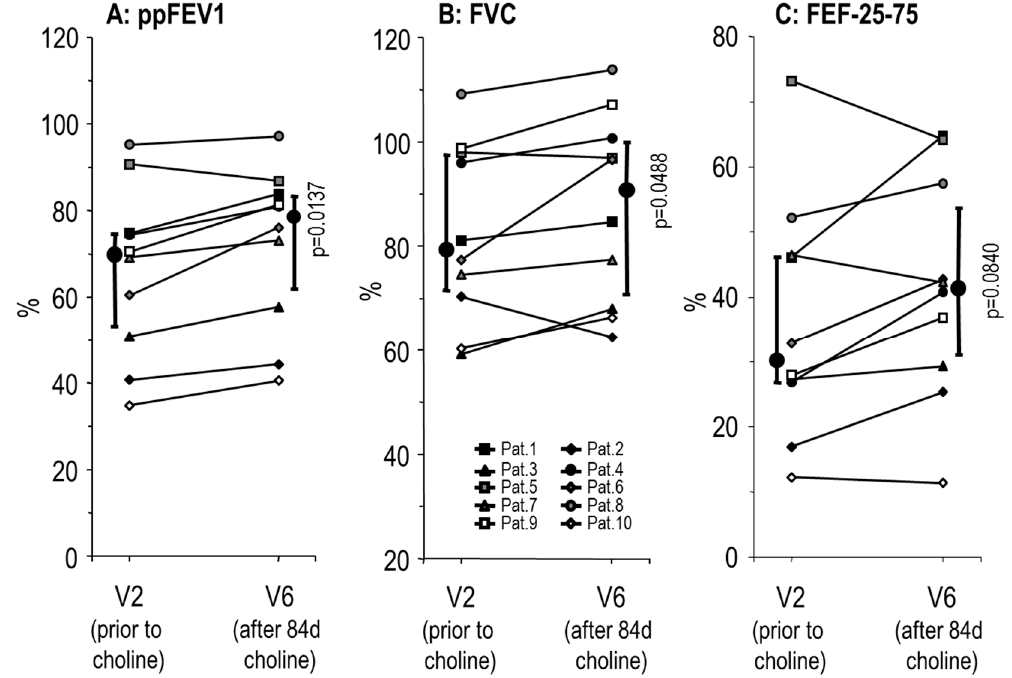
Figure 4. Effects of choline supplementation on lung function. Data indicate values prior to (V2) and after 84 (84–91) days (V6) supplementation with 3 × 1 g/day choline chloride. Data indicate age-corrected Relative Forced Expiratory Volume in 1 second (Tiffeneau Index; ppFEV1) ( A ), Forced Vital Capacity (FVC) ( B ) and Forced Expiratory Flow at 25–75% of the pulmonary volume (FEF25-75) ( C ). Small symbols and thin lines indicate individual values of patients, whereas large symbols and thick bars indicate medians and interquartile ranges. p significance level.